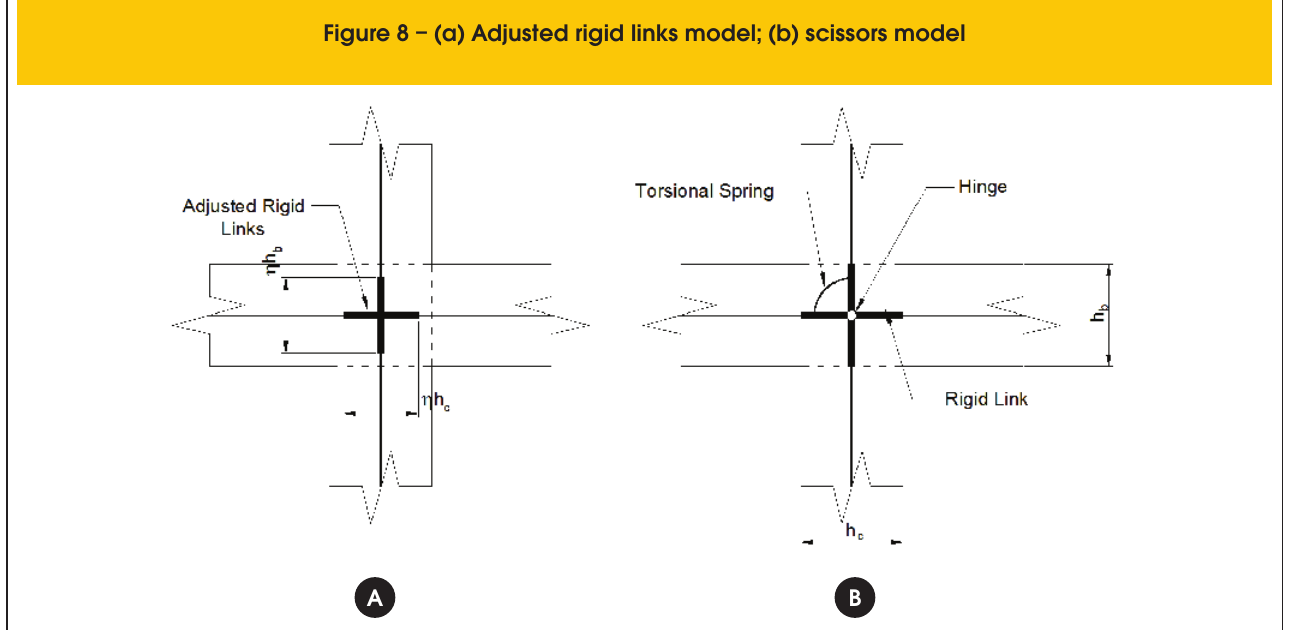
Figure 8 – (a) Adjusted rigid links model; (b) scissors